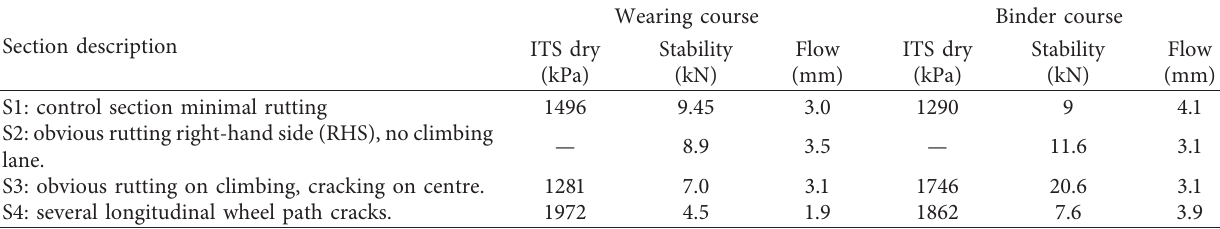
Table 6: ITS and Marshall results.